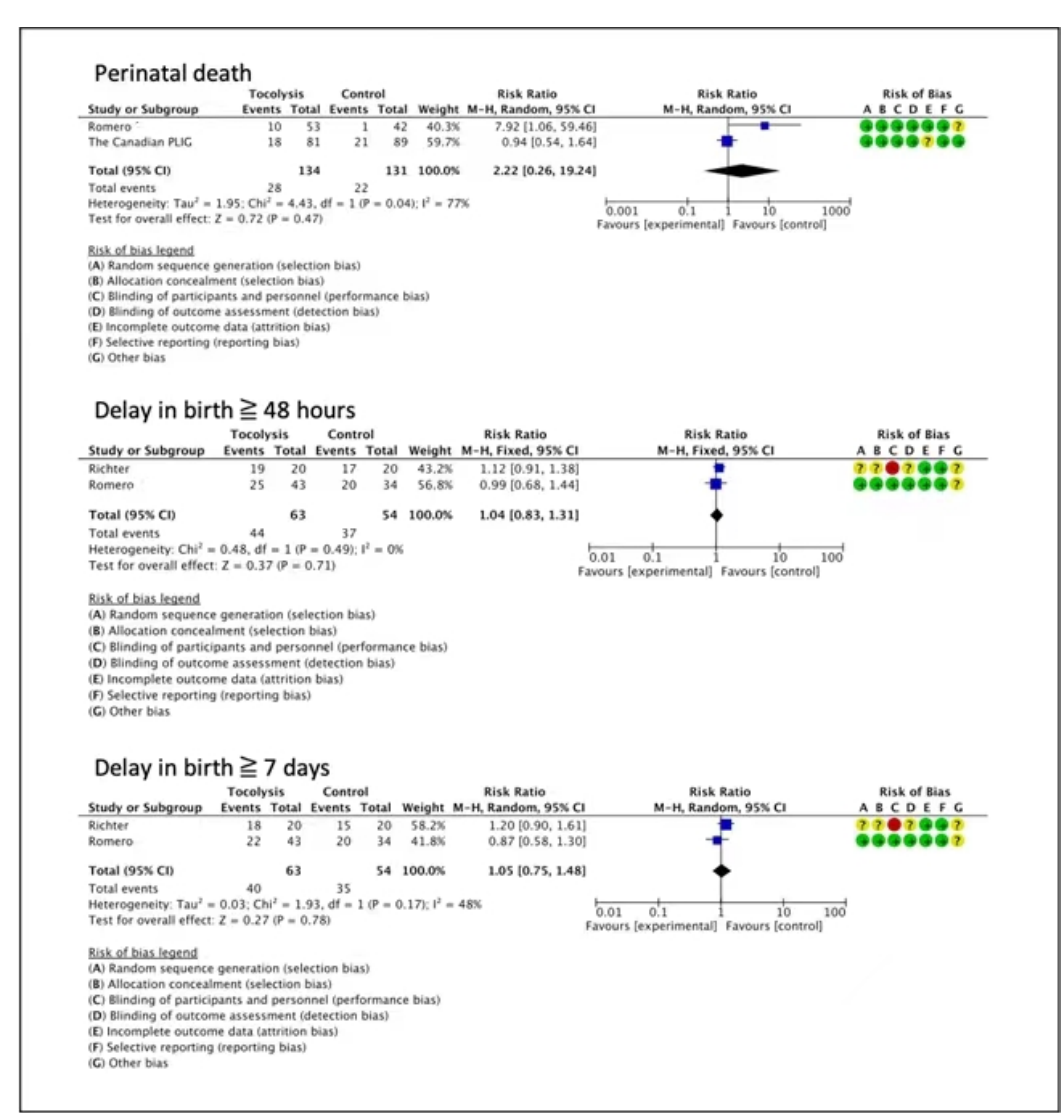
Figure 2. Tocolytics compared to placebo or no treatment—extreme prematurity (RCTs) [27–29].